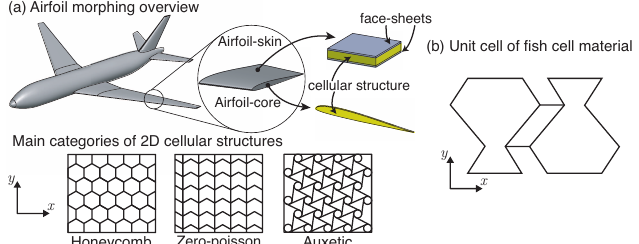
Figure 5. ( a ) Complete schematic overview of airfoil morphing and main categories of 2D cellular structures, and ( b ) unit-cell of the zero-Poisson’s ratio cellular material termed as“Fish cell” (figure adapted from in [125]).